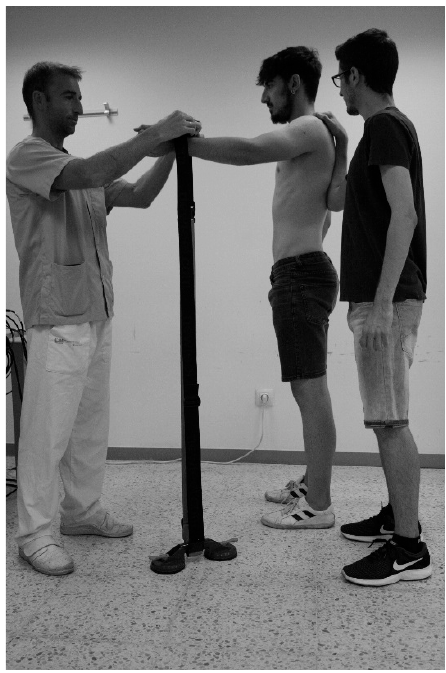
Figure 1. Attachment system for dynamometer measurements.